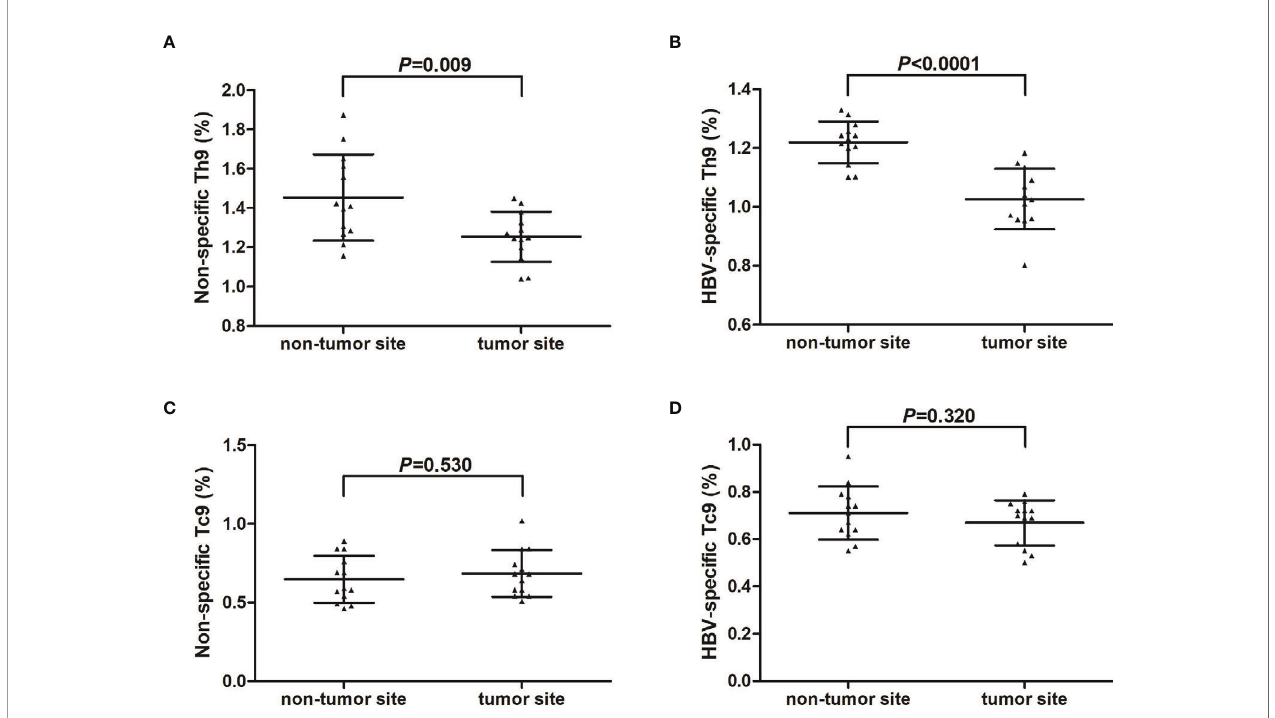
FIGURE 4 | Liver-in fi ltrating non-speci fi c and HBV core-speci fi c Th9/Tc9 cells in hepatitis B-related hepatocellular carcinoma (HCC). Intrahepatic lymphocytes (IHLs) were isolated from fresh HCC specimens and non-tumor site liver specimens in thirteen HCC patients (seven in stage A and six in stage B) who underwent hepatic carcinectomy. IHLs were stimulated with either phorbol myristate acetate (50 ng/ml)+ionomycin (1 m g/ml) (for non-speci fi c stimulation) or HBsAg (for HBV-speci fi c stimulation) in the presence of brefeldin A (10 m g/ml) for 6 hours, and were then stained with anti-CD3, anti-CD4, anti-CD8, and anti-IL-9. CD3 + CD4 + IL-9 + Th9 cells and CD3 + CD8 + IL-9 + Tc9 cells were analyzed by fl ow cytometry. (A) The percentage of liver-in fi ltrating non-speci fi c Th9 cells was compared between non-tumor site and tumor site. Signi fi cance was assessed using Student t test. (B) The percentage of liver-in fi ltrating HBV-speci fi c Th9 cells was compared between non-tumor site and tumor site. Signi fi cance was assessed using Student t test. (C) The percentage of liver-in fi ltrating non-speci fi c Tc9 cells was compared between non-tumor site and tumor site. Signi fi cance was assessed using Student t test. (D) The percentage of liver-in fi ltrating HBV-speci fi c Tc9 cells was compared between non-tumor site and tumor site. Signi fi cance was assessed using Student t